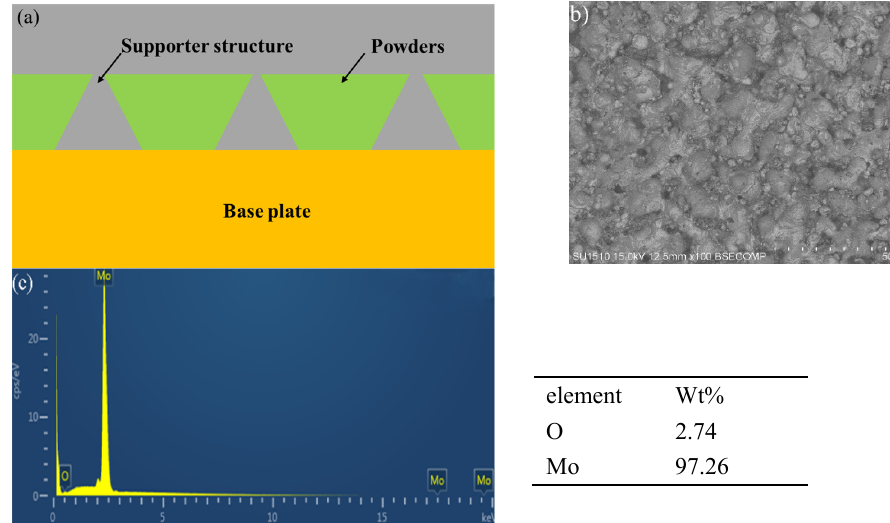
Figure 11. ( a ) the morphology of support structure, ( b ) top face morphology of Mo sample after adding support, ( c ) the EDS analysis of element content of SLM fabricated Mo samples.